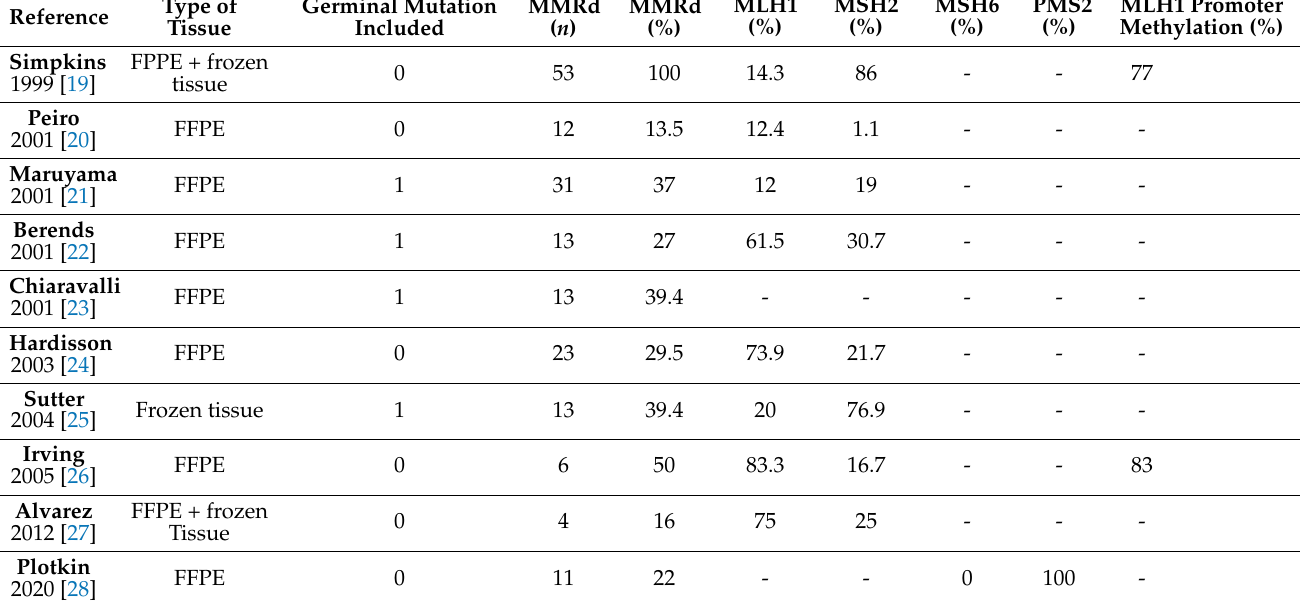
Table 1. Differences in immunohistochemistry protein losses in tumors with microinstability in endometrial cancer using the expression of two